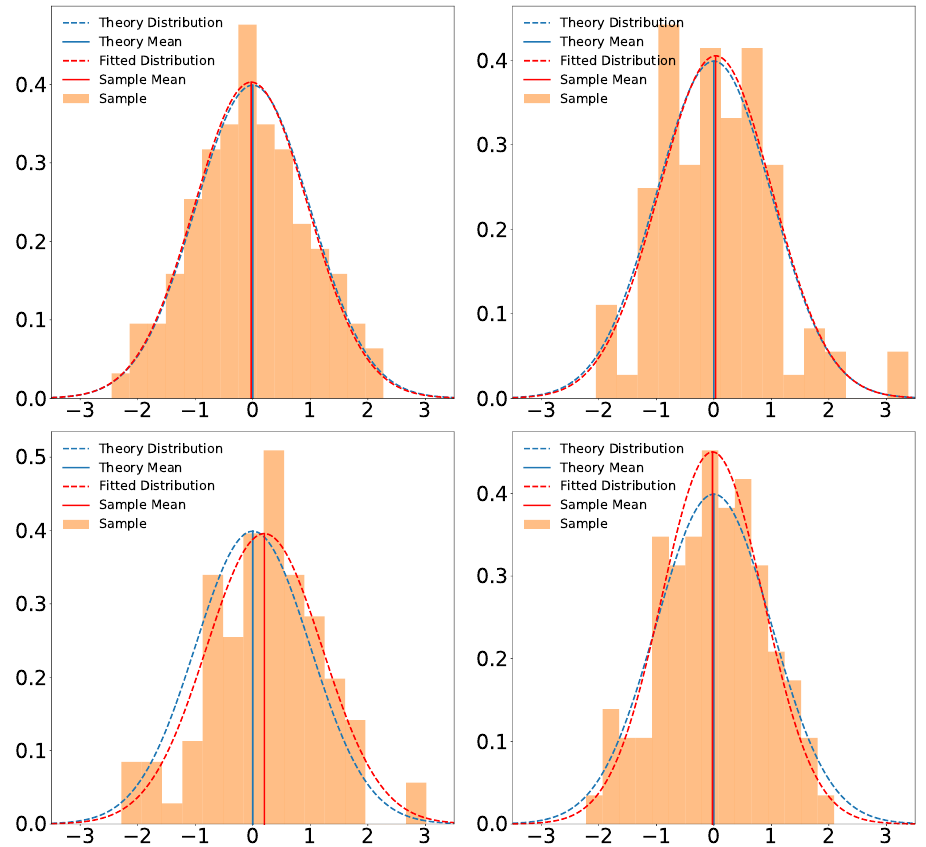
Figure 4: Results from typical pseudo-experiments with n = 100 events each, drawn from the true distribution (25) (the blue dashed line). Each panel shows an orange- shaded normalized histogram of the sampled data, as well as a Gaussian fit to it (red dashed line) and the derived sample mean µ (red solid line). The four pseudo- n experiments depicted here illustrate different levels of agreement between the sam- pled data and the underlying theoretical distribution. In the upper row, the fit to the data has similar mean µ and standard deviation σ as the theory distribution, but n n in the left (right) panel in addition it has a good (bad) χ 2 . In the lower left (lower right) panel the mean (standard deviation) of the fit is noticeably different from the true